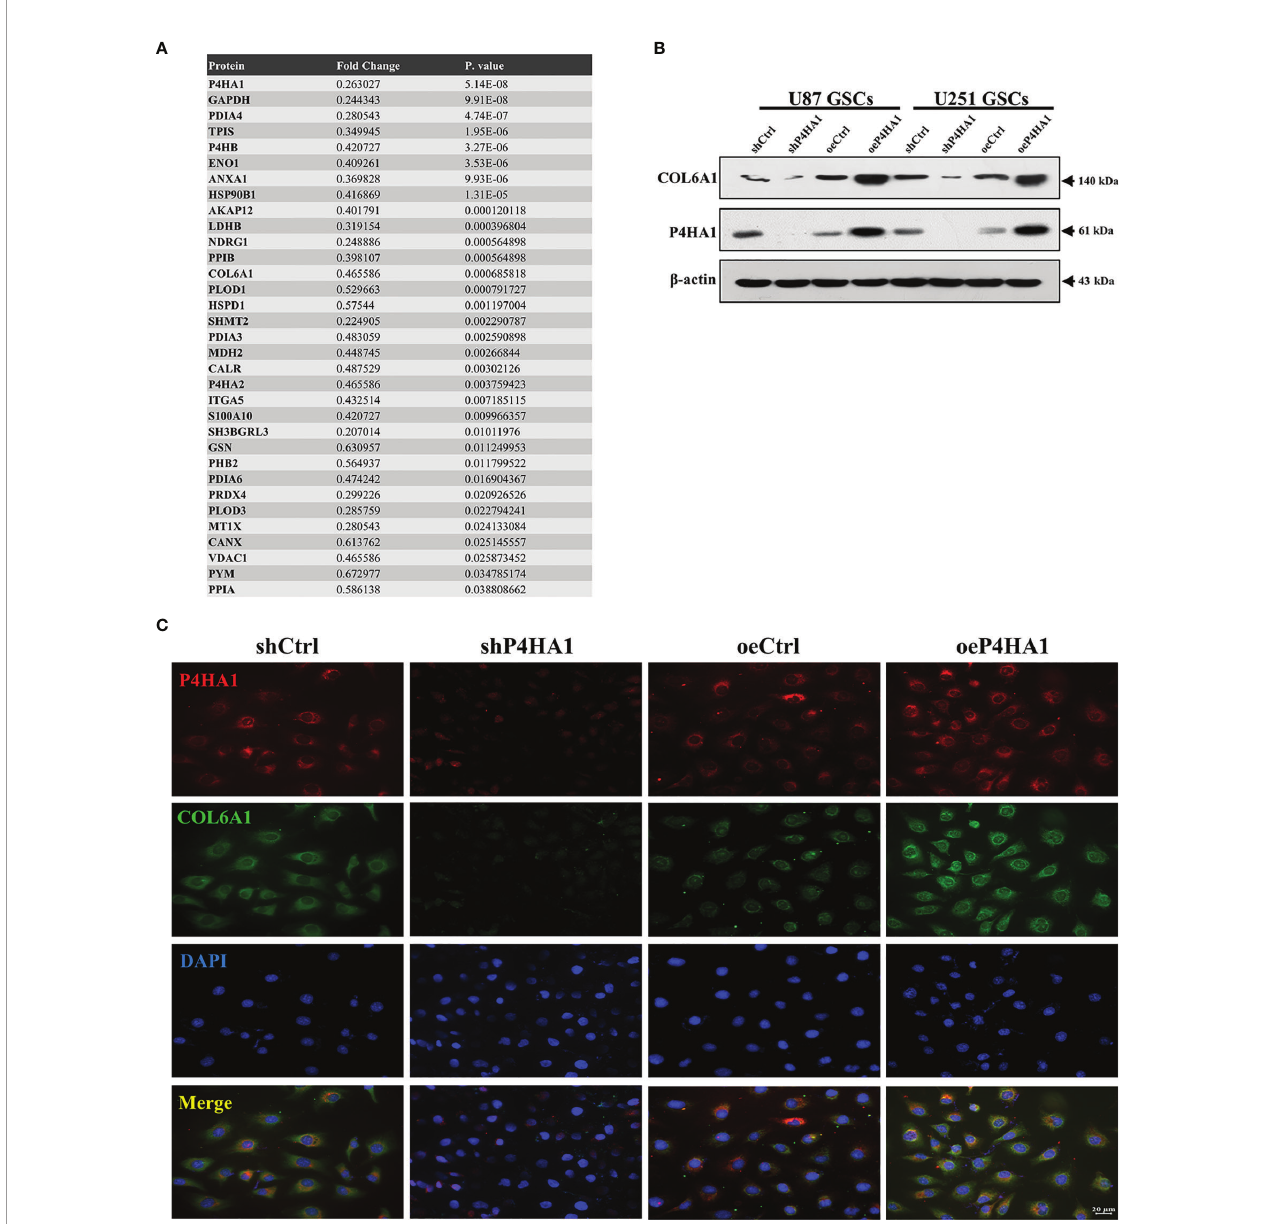
FIGURE 4 | Candidate gene COL6A1 was screened as a downstream effector of P4HA1. (A) Liquid Chromatography-Mass Spectrometry results of U251 GSC- derived ECs transfected with shP4HA1 and shCtrl vector. Fold change was determined by the protein abundances. (B) Western blot analysis showing that heightened P4HA1 expression was associated with increased COL6A1 expression in both U87 and U251 GSCs under hypoxic transdifferentiation. (C) Immuno fl uorescence showing that P4HA1 expression was positively correlated with COL6A1 expression in U251 GSCs-derived ECs (scale bar=20 m